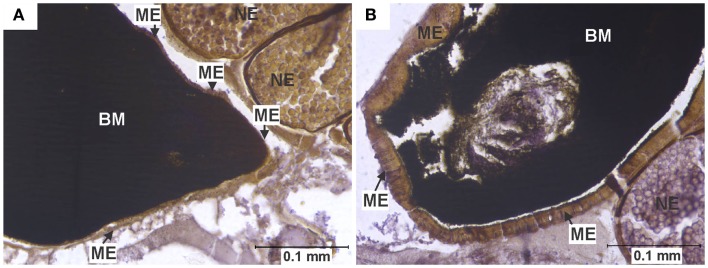
Midgut epithelium necrosis. (A) Section of the posterior midgut of a specimen of the HVP strain, 2 days after ingesting a blood meal containing 5-log PFU of WEEV per 0.1 ml blood. Notice how the epithelium has become necrotic, being reduced to a very thin band, with neither discernible cell boundaries nor traces of cytoplasm or organelles. (B) Comparable section of posterior midgut in an uninfected control, where no necrosis is observed. BM, blood meal (in the midgut lumen); ME, midgut epithelium; NE, non-infected egg.